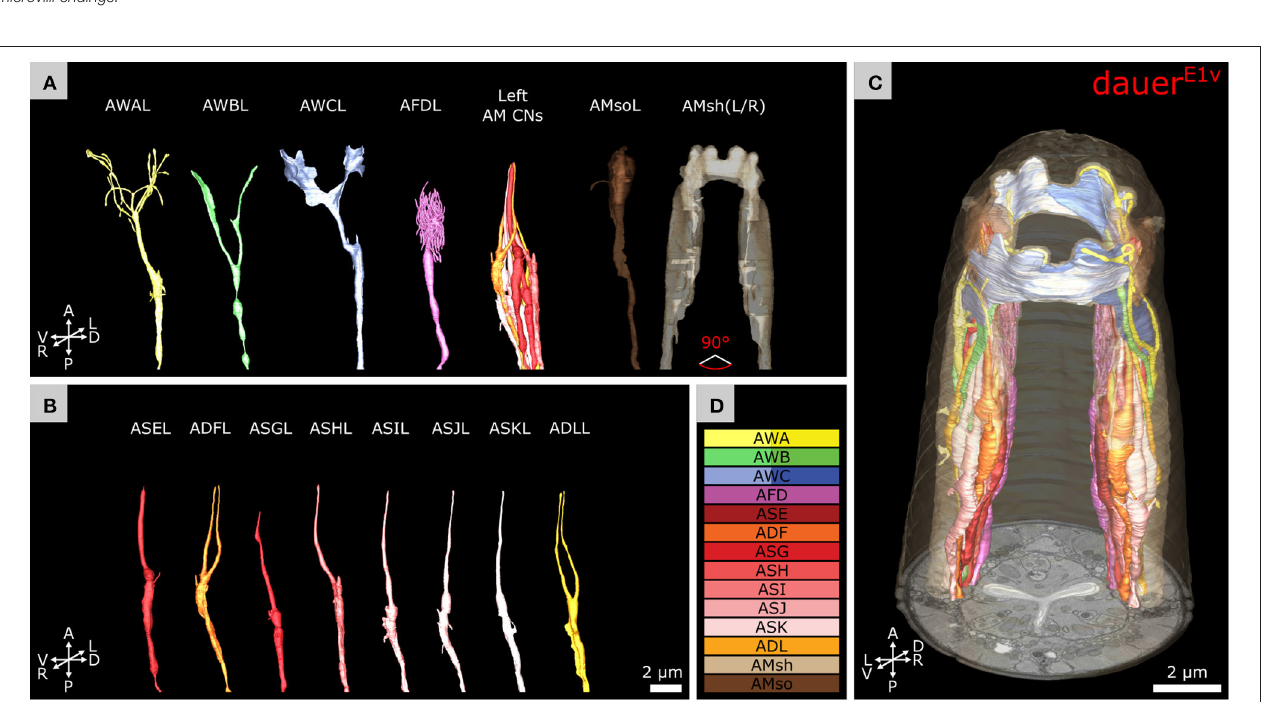
FIGURE 6 | Volumetric reconstruction of the anterior sensory endings of amphid neurons in dauer. (A) Models of sensory endings of all 12 left amphid neurons, of which eight are amphid channel neurons shown as a group (AM CNs), and models of the endings of their two support cells AMsoL and AMshL, where the latter is fused with AMshR. Left cells are shown as an example. (B) Models of sensory endings of all eight left amphid channel neurons from A. ADFL and ADLL are double ciliated while all others are single ciliated. (C) Models of sensory endings of all amphid neurons and their support cells. (D) Names and color code of cells